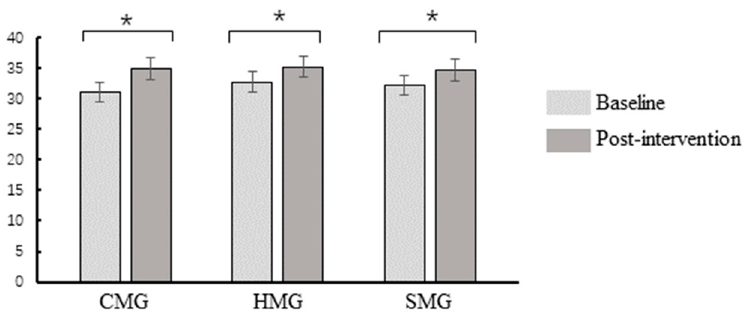
Figure 4. Toronto Mindfulness Scale (TMS) difference within-group before and after post-intervention. CMG: calm music group, HMG: happy music group, SMG: sad music group; * p < 0.05.